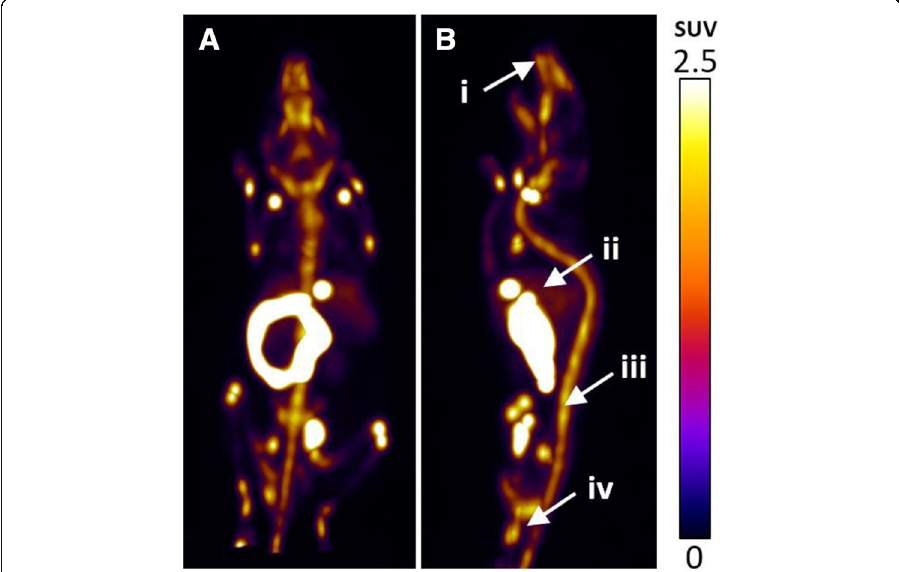
Fig. 5 Representative coronal ( a ) and sagittal ( b ) PET/CT images of [ 18 F]2 in C57BL/6 female mice at 50 min p.i. White arrows indicate the bone (i), liver (ii), small intestine (iii) and muscle (iv). Extensive skeletal uptake of [ 18 F]2 is indicative of